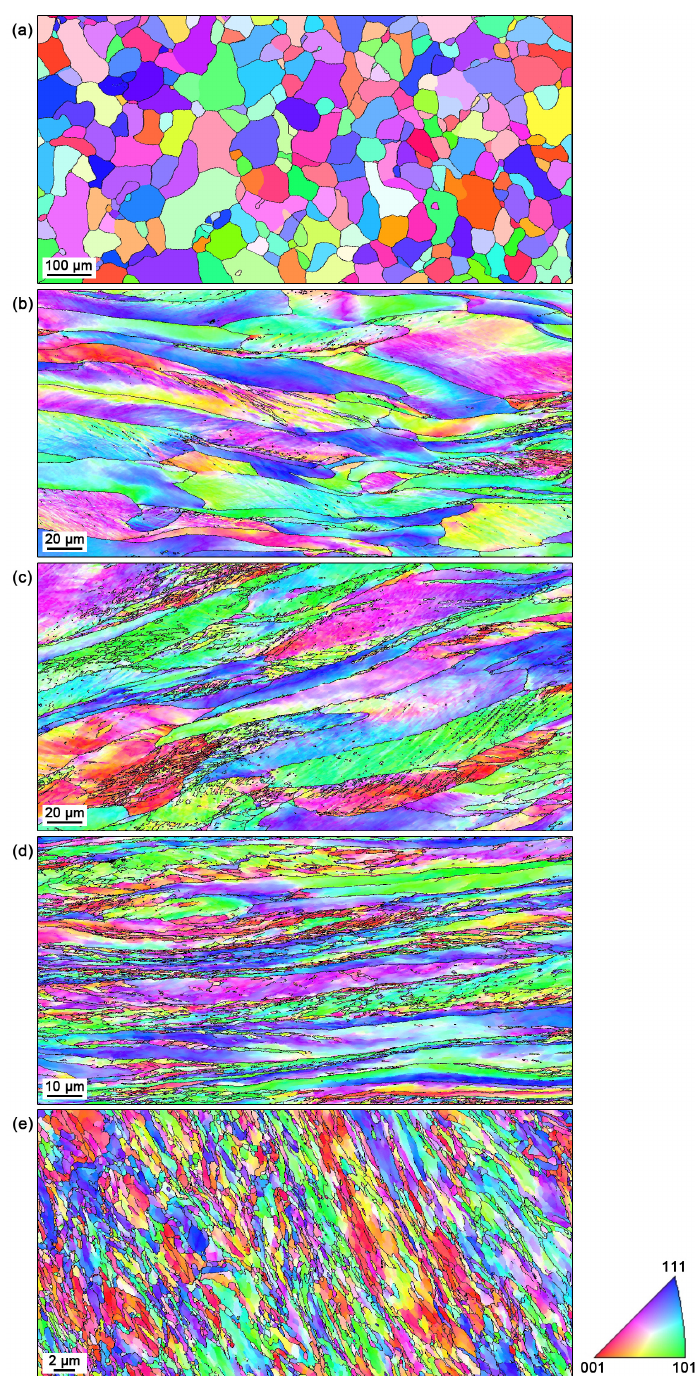
Figure 1. Inverse pole figure maps for ARMCO ® iron ( a ) as-received; ( b ) after cold rolling to 64% rolling reduction; ( c ) after one ECAP pass; ( d ) after one ECAP pass followed by cold rolling to 64% rolling reduction; ( e ) after five ECAP passes along route B C . Black lines indicate high angle grain boundaries (>15° misorientation). Please note the different scale bars.